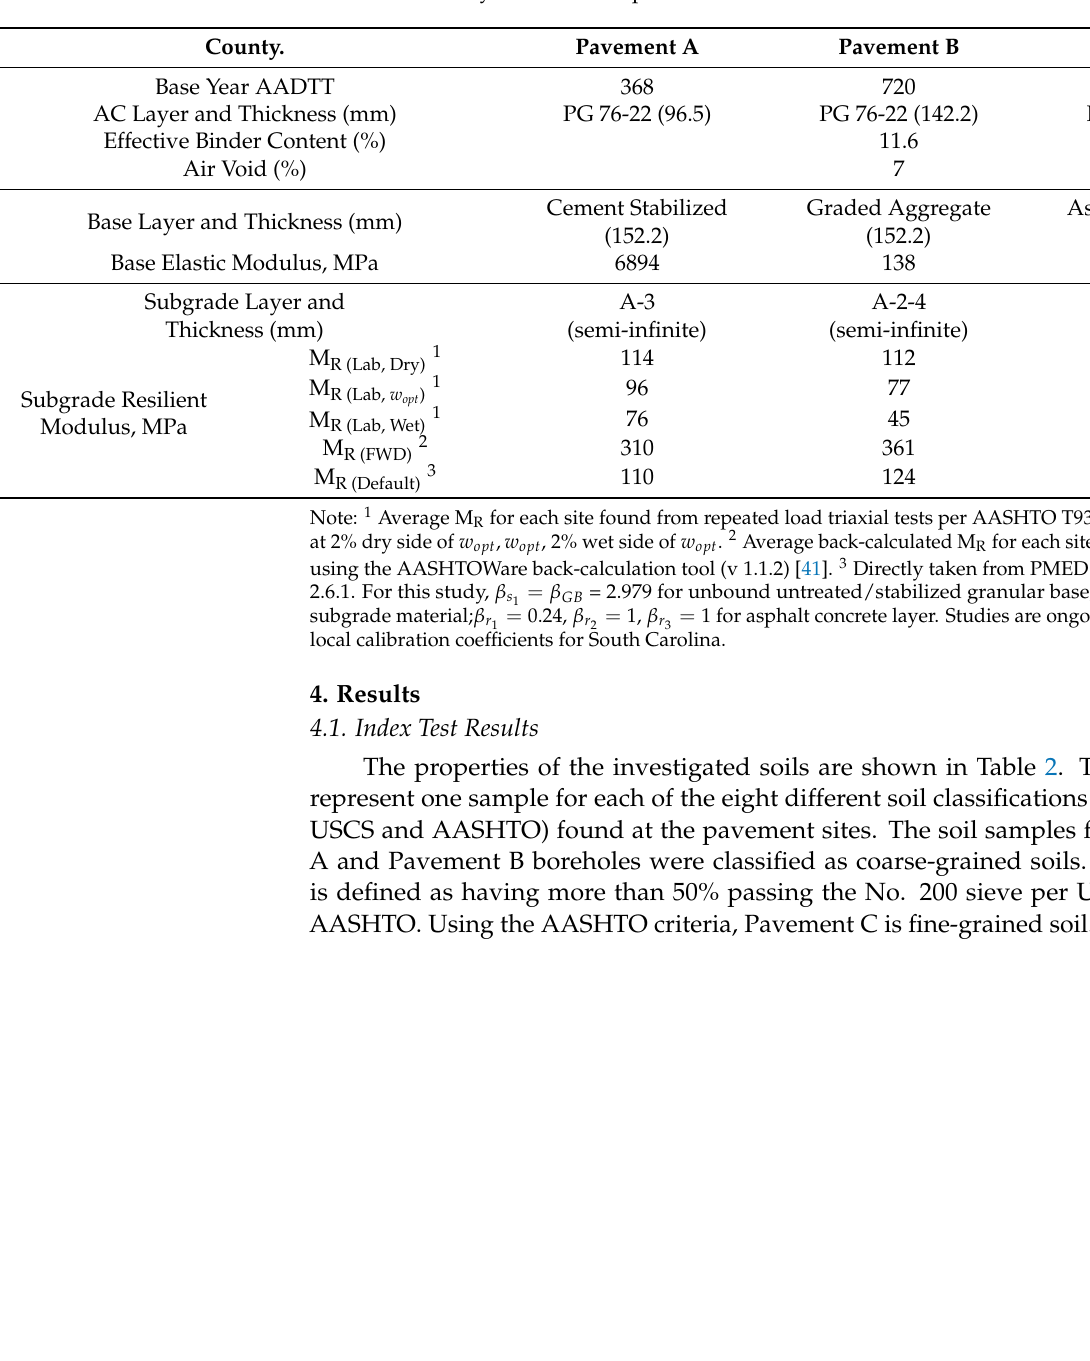
Table 1. Summary of MEPDG